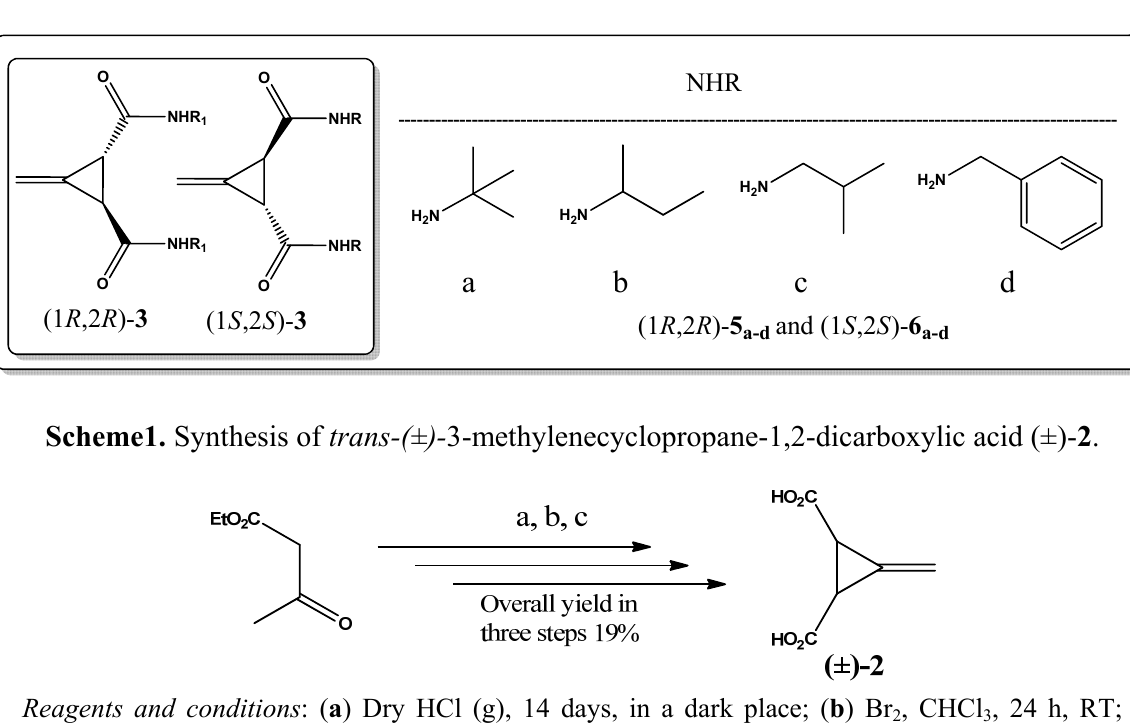
Figure 1. Substituted bis-amide ligands derived from Feist’s